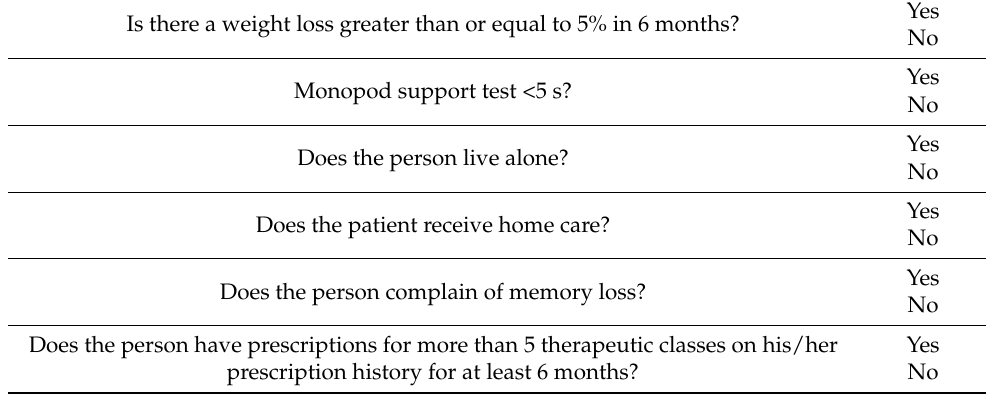
Table 1. Zulfiqar Frailty Scale